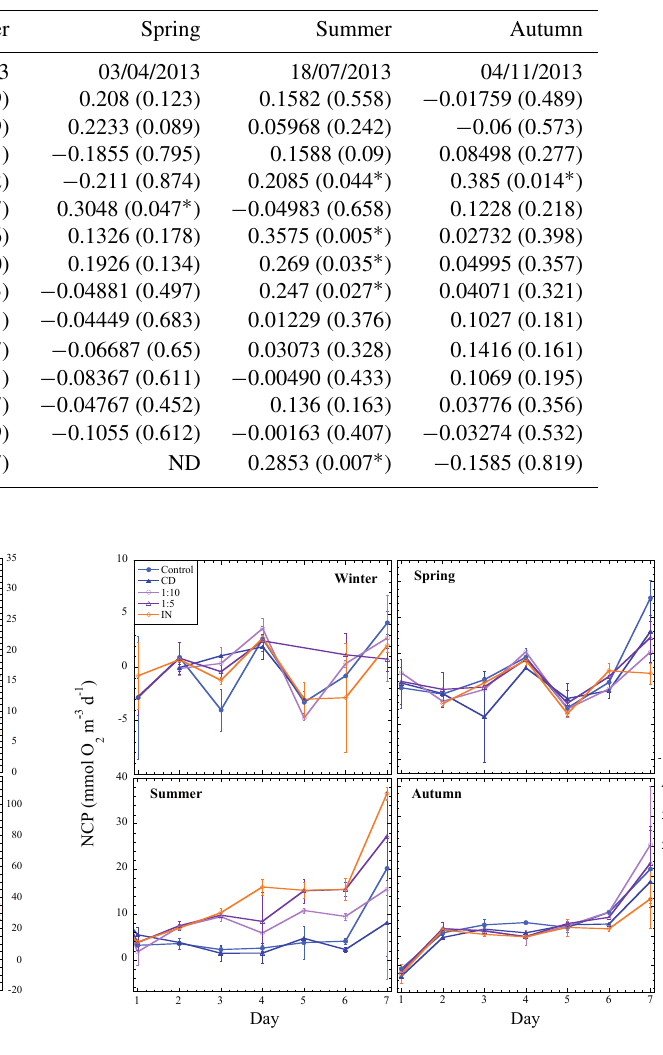
Table 4. Results of MANTEL tests (Pearson’s r ) to examine whether absolute shifts in bacterioplankton community composition were correlated with absolute changes specific environmental variables and metabolic rates measured in the incubations during the experiments. Significance is indicated in parentheses.